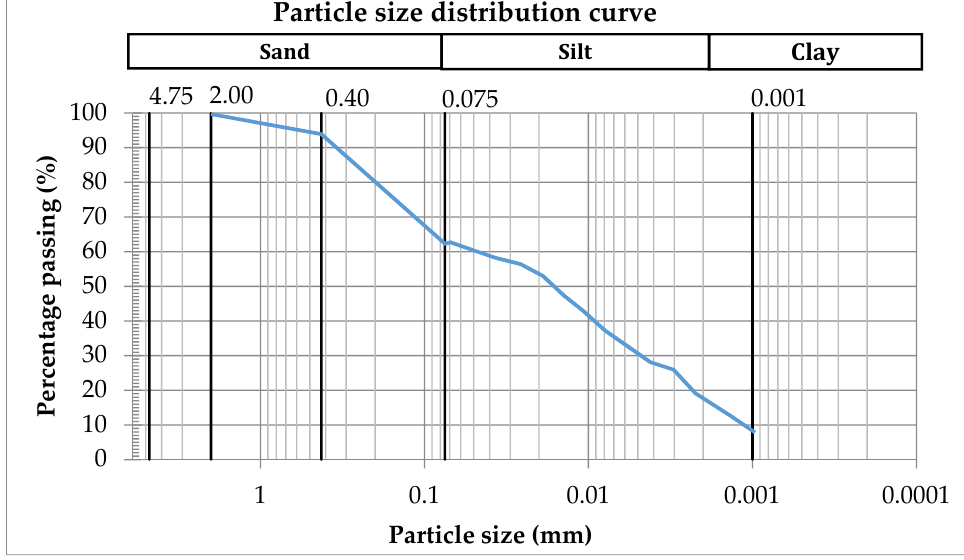
Figure 2. Particle Size Distribution Curve.